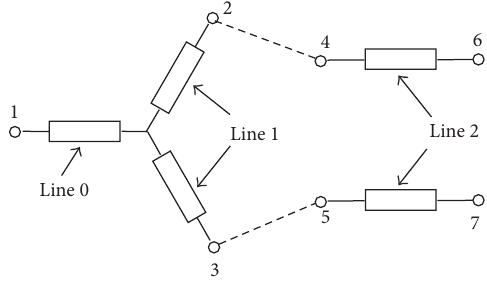
Figure 16: Equivalent circuit of the feeding